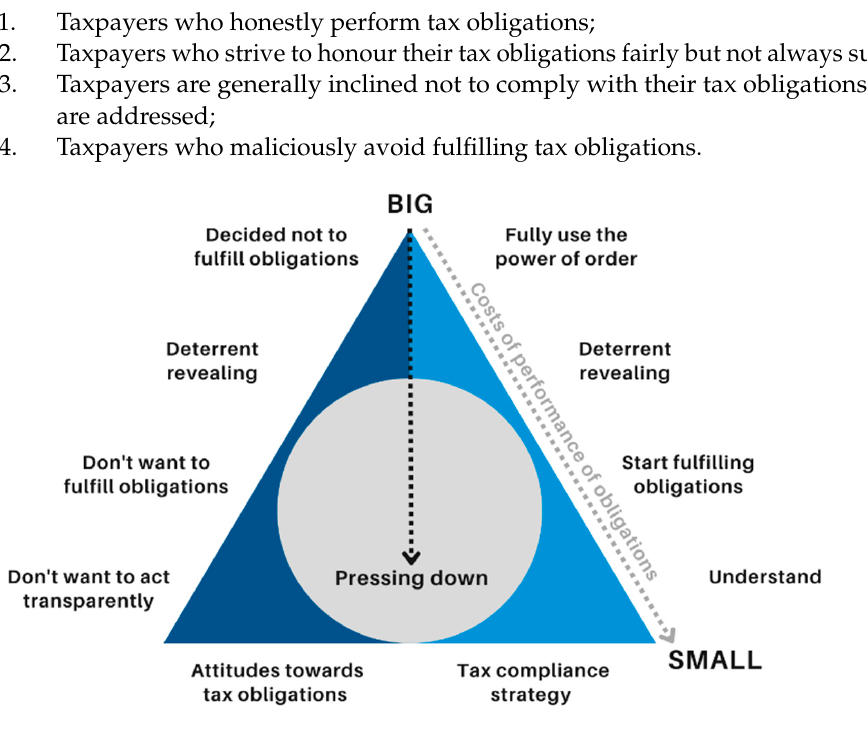
Figure 2. Taxpayers’ grouping concerning the fulfilment of tax obligations.